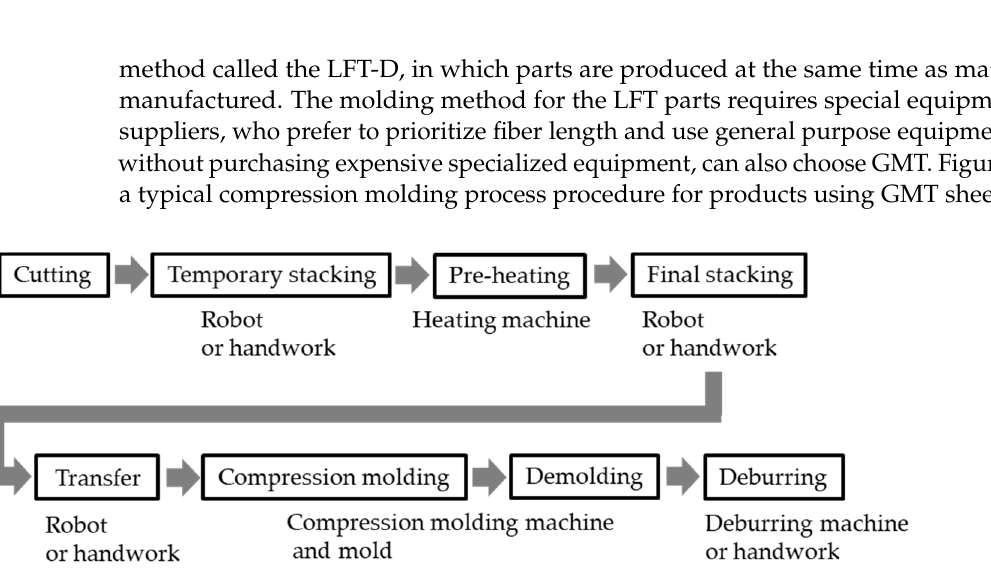
Figure 1. Typical compression molding process for glass-fiber-mat-reinforced thermoplastic (GMT) parts.